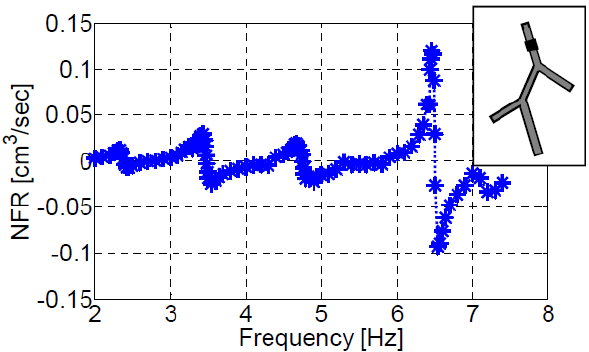
Figure 9. The dependence of the NFR on the phase lag between two actuators located on vessels #1 and #2 of configuration III-b. The first actuator was located on vessel #1 at X C / L 1 = 0.75. Three locations of the second actuator are presented. The actuation frequency was 4.4 Hz, close to the fourth natural frequency of the system. Bioengineering 2018 , 5 , x FOR PEER REVIEW